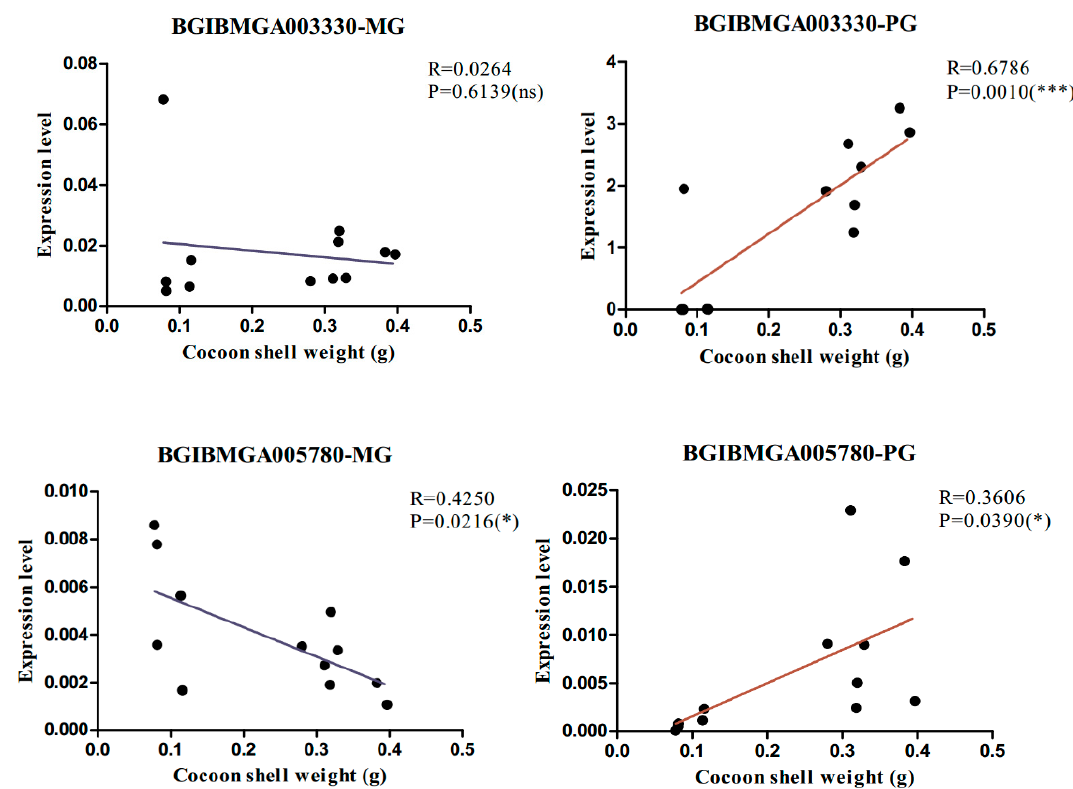
Figure 6. Association analysis of partial gene expression levels with cocoon shell weight (CSW). In the figure, only the association analysis diagram of the associated significant gene is listed, ns: Not significant; *: p ≤ 0.05; **: p ≤ 0.01; ***: p ≤